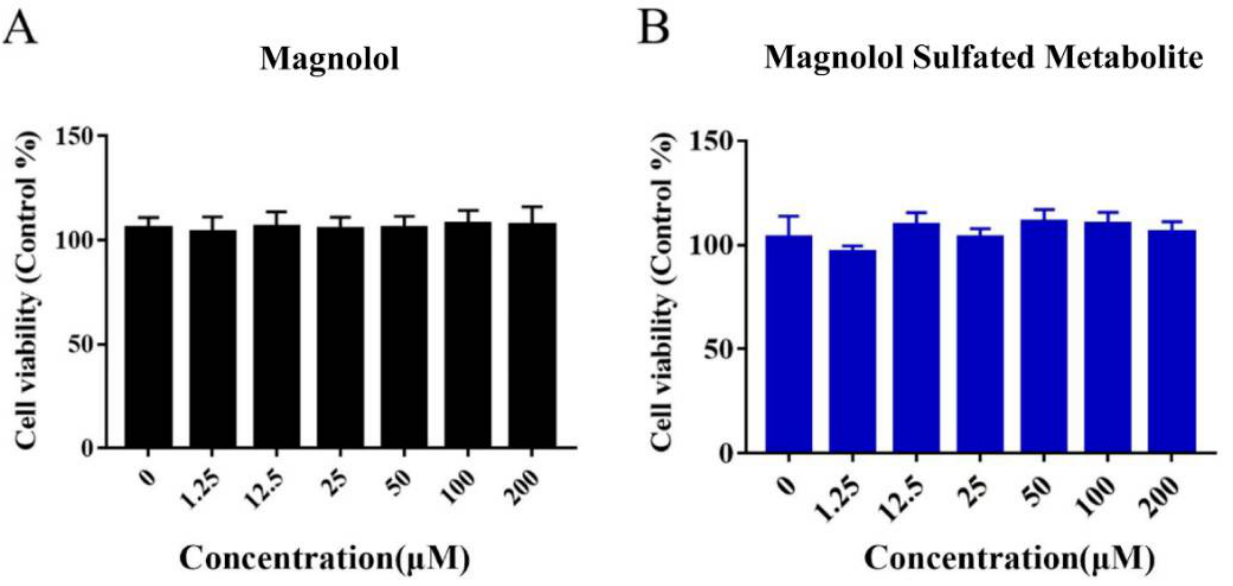
Figure 7. The effect of magnolol ( A ) and its sulfated metabolite ( B ) on RAW264.7 cell viability at a